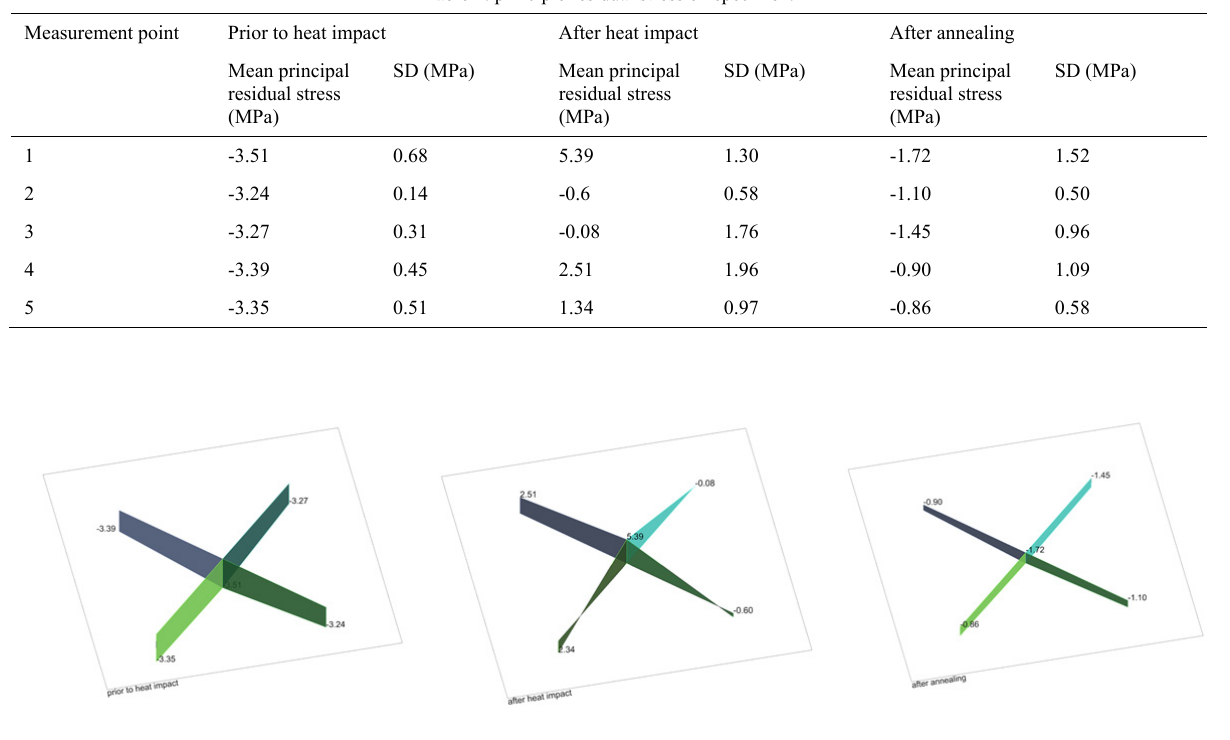
Table 2: principle residual stress on specimen.